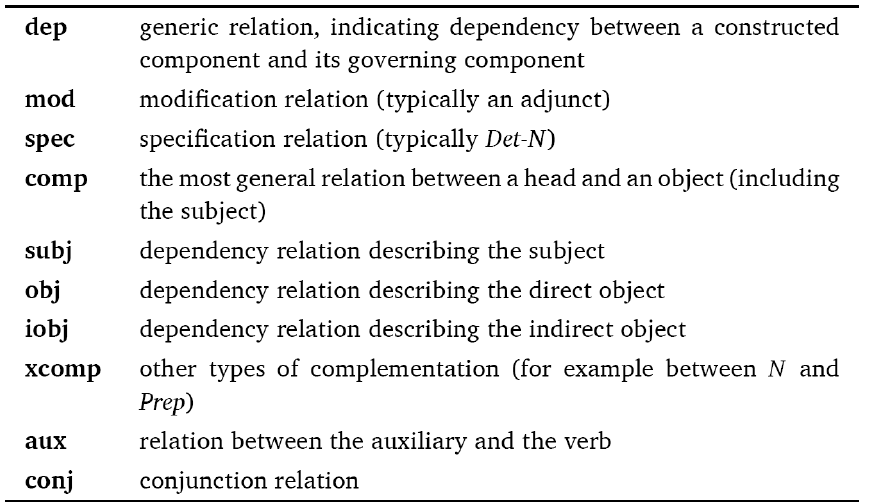
Figure 2. List of dependencies in property grammar from Blache [20] (p.